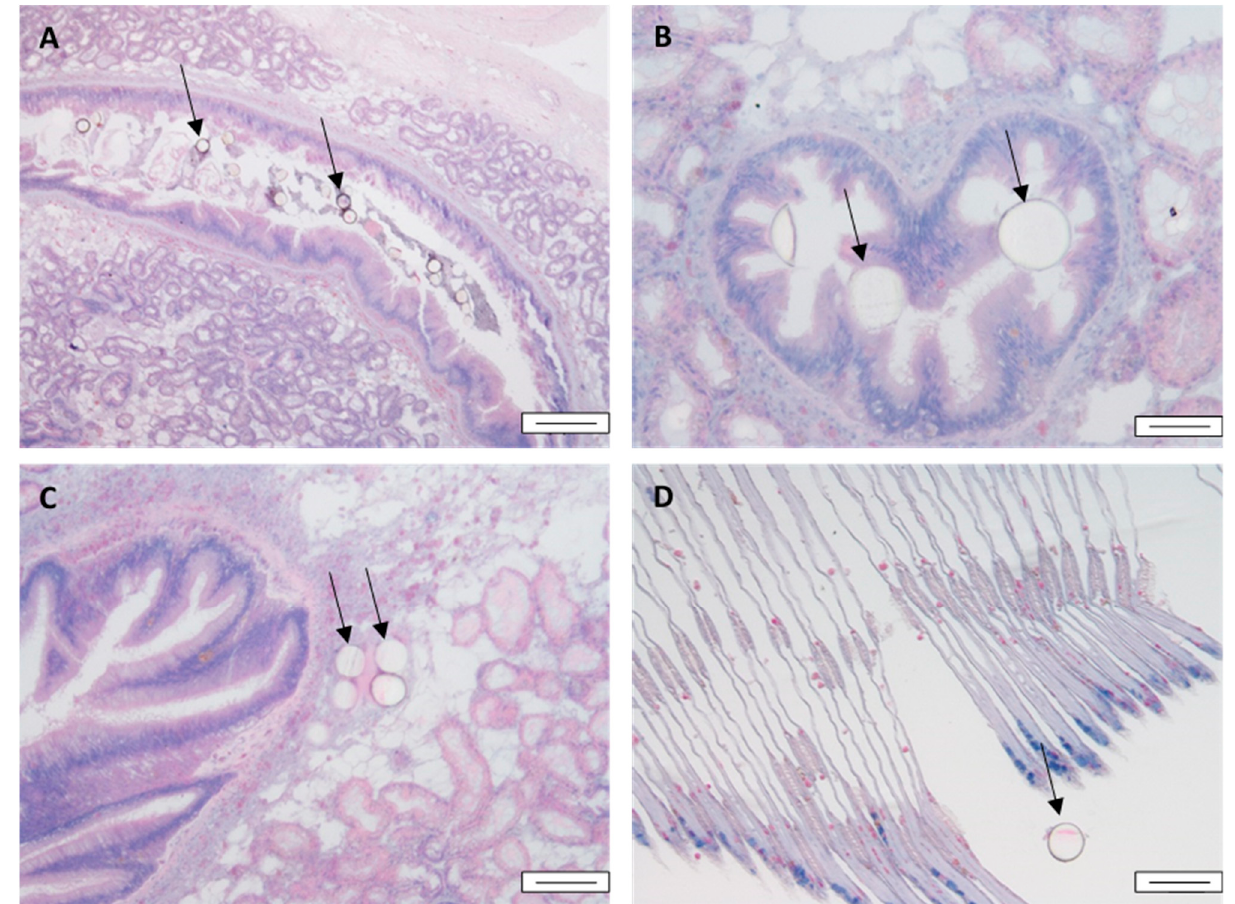
Figure 1. Micrographs of H&E-stained sections of digestive gland and gills of mussels after 1 day of exposure to pristine 45 µm MPs. ( A ) MPs in the lumen of the stomach after exposure to 100 particles/mL; ( B ) MPs in the lumen of a duct after exposure to 1000 particles/mL; ( C ) MPs in the connective tissue after exposure to 1000 particles/mL; ( D ) MPs outside a gill filament after exposure to 100 particles/mL. Black arrows point to MP particles. Scale bars: ( A ) 200 µm, ( B ) 50 µm, ( C , D ) 100 µm.